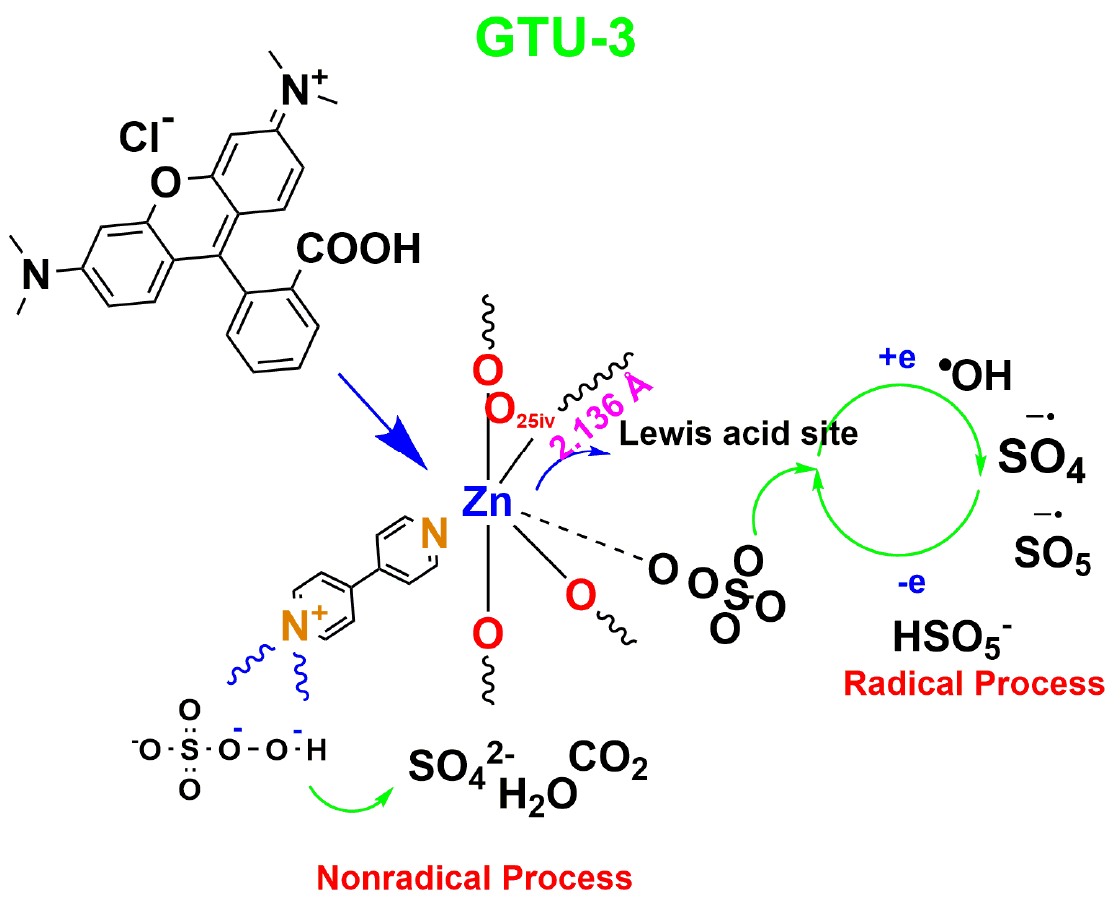
Figure 7. The radical and nonradical PMS activation process in the presence of GTU-3.